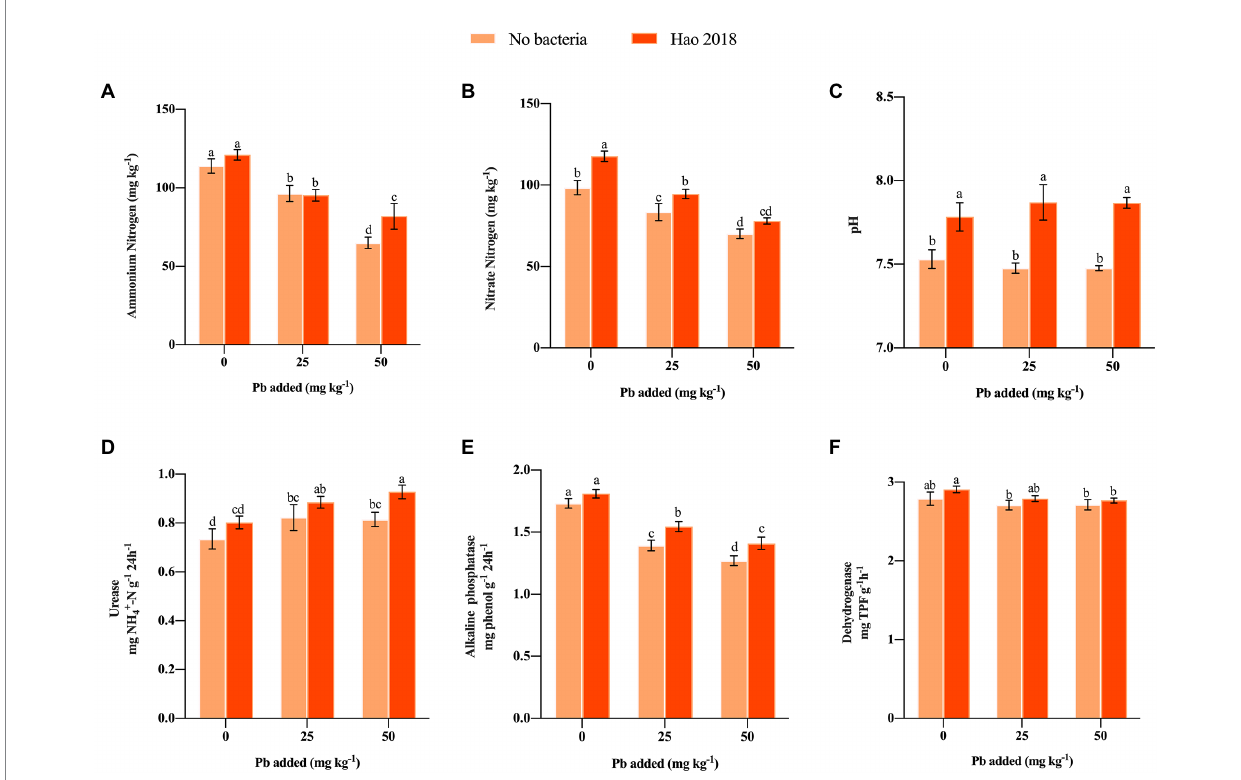
FIGURE 4 Effect of Hao 2018 on NH 4+ -N content (A) , NO 3 − -N content (B) and pH (C) in rhizospheric soil. The influence of Hao 2018 on urease (D) , alkaline phosphatase (E) and dehydrogenase (F) activity in rhizospheric soil. Each bar represents the mean ± SD ( n = 4). Bars marked with the same letter are not significantly different ( p > 0.05).